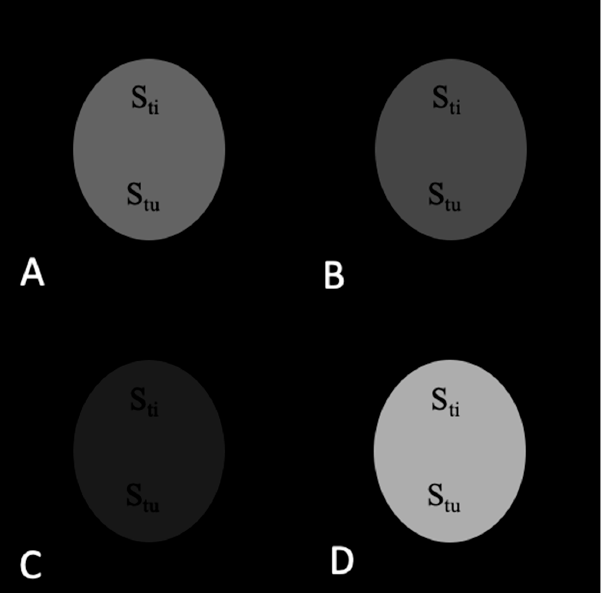
Figure 3. MR images of the tumor phantom model before contrast injection: ( A ) T 1 w. ( B ) T 2 w. ( C ) Subtracted T 1 w − T 2 w. ( D ) Added T 1 w + T 2 w. TC = 1.00 in all images.